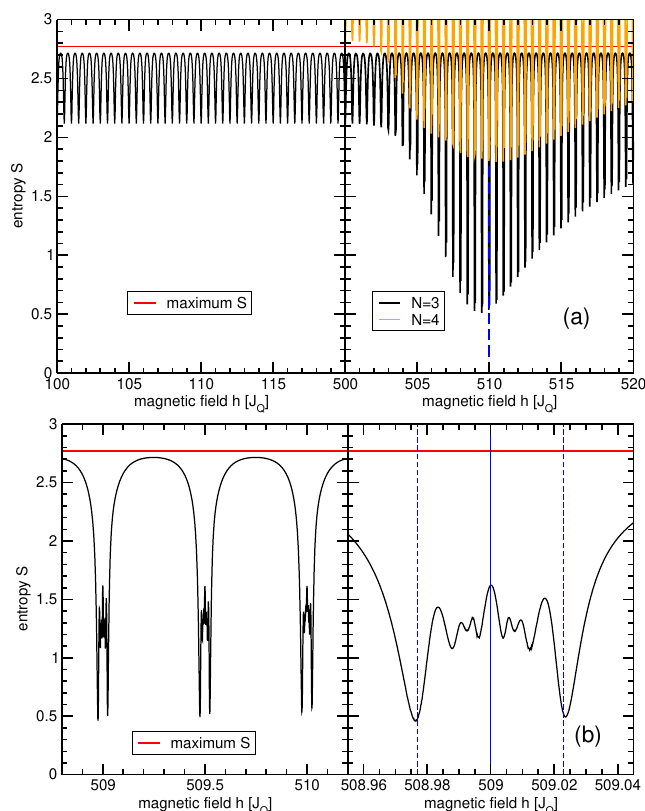
Figure 1: (a) Residual entropy of the limiting density matrix V obtained after infinite 0 = 0.02 J number of pulses vs. the applied magnetic field for J and z = 1 / 1000; max Q 1 Tesla corresponds roughly to 50 J . Resonances of the electronic spin occur every Q ∆ h = 0.5 J ; resonances of the nuclear spins occur every ∆ h = 500 J . The blue Q Q / ( 2 z ) from the nuclear resonance. (b) dashed line depicts an offset of ∆ h = ± J max Zooms into intervals of the magnetic field where the lowest entropies are reached. The blue dashed lines depict an offset of ∆ h = ± A from the electronic max